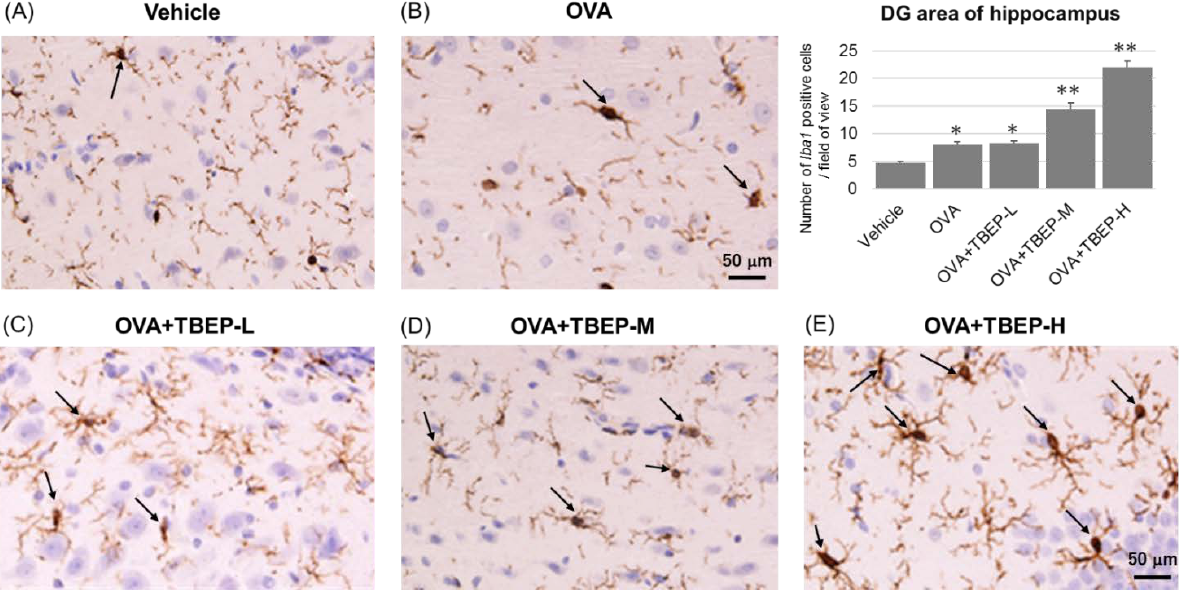
Figure 7. Representative photomicrographs of the dentate gyrus of the hippocampus. Microglia marker Iba1 immunoreactivity in ( A ) vehicle, ( B ) OVA, ( C ) OVA + TBEP-L, ( D ) OVA + TBEP-M and ( E ) OVA + TBEP-H. Black arrows indicate activated microglia. (Scale bar = 50 μm). Number of Iba1-positive cells located within the DG area of the hippocampus was quantified in a high power field under microscopy (histogram). (n = 3, * p < 0.05, ** p < 0.01 vs. vehicle alone).